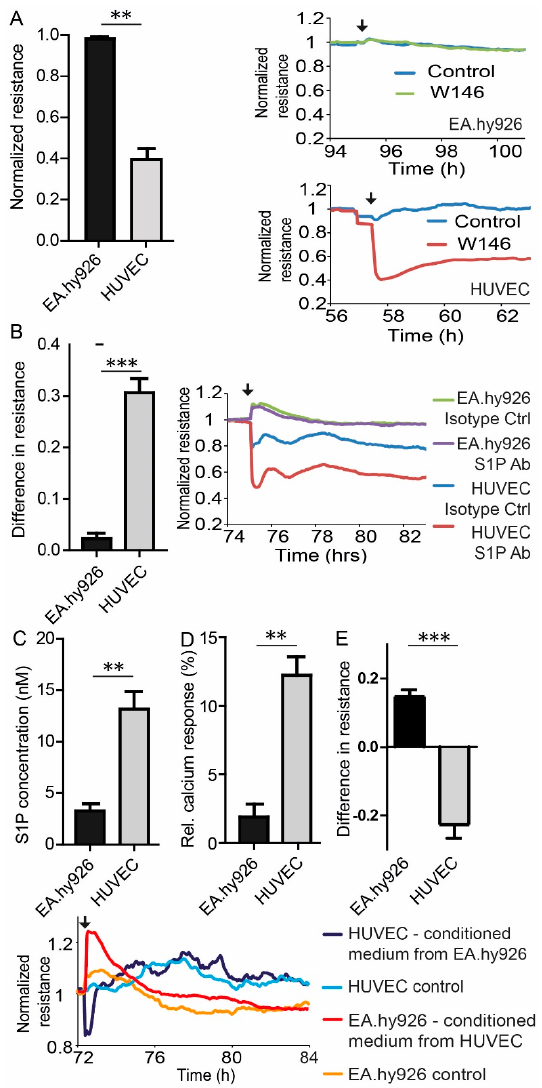
Figure 2. Comparison of S1P-signaling in HUVEC and EA.hy926. ( A ) Resistance following treatment with 3 µM of the S1PR1 antagonist W146. Normalized resistance values were taken at the time of the established maximal change of resistance after W146 treatment divided by resistance of carrier-treated control cells at the same time and are means ± SEM, n = 3, ** p < 0.001, determined by two-sided Student’s t-test. Line plots represent one experiment out of three with black arrows indicating the addition of W146 or vehicle at the corresponding time. ( B ) Resistance following treatment with 120 µ g / mL of the anti-S1P antibody Sphingomab. The di ff erence in resistance is the di ff erence between S1P-antibody treatment and isotype control antibody treatment taken at the time of maximal change of resistance after treatment. Shown are means ± SEM, n = 3, *** p < 0.001, determined by a two-sided Student’s t-test. Line plot represents one experiment out of three with a black arrow indicating the addition of Sphingomab (S1P Ab) or isotype control antibody (Isotype Ctrl) at the corresponding time. ( C ) LC-MS / MS quantification of extracellular S1P production by EA.hy926 and HUVEC. ( D ) Intracellular calcium response in rat hepatoma HTC4 cells transfected with human S1PR1 and the human G α i subunit of trimeric G proteins, stimulated with lipid extracts from EA.hy926 and HUVEC as indicated. ( E ) Resistance following medium exchange. The di ff erence in resistance is the di ff erence between exchange of conditioned medium and control medium at the time of maximal change of resistance after medium exchange. Line plot represents one experiment out of three with a black arrow indicating the exchange of medium at the corresponding time, controls represent unconditioned medium. ( C – E ) Data are means ± SEM, n = 3, ** p < 0.01, *** p < 0.001, determined by a two-sided Student’s t